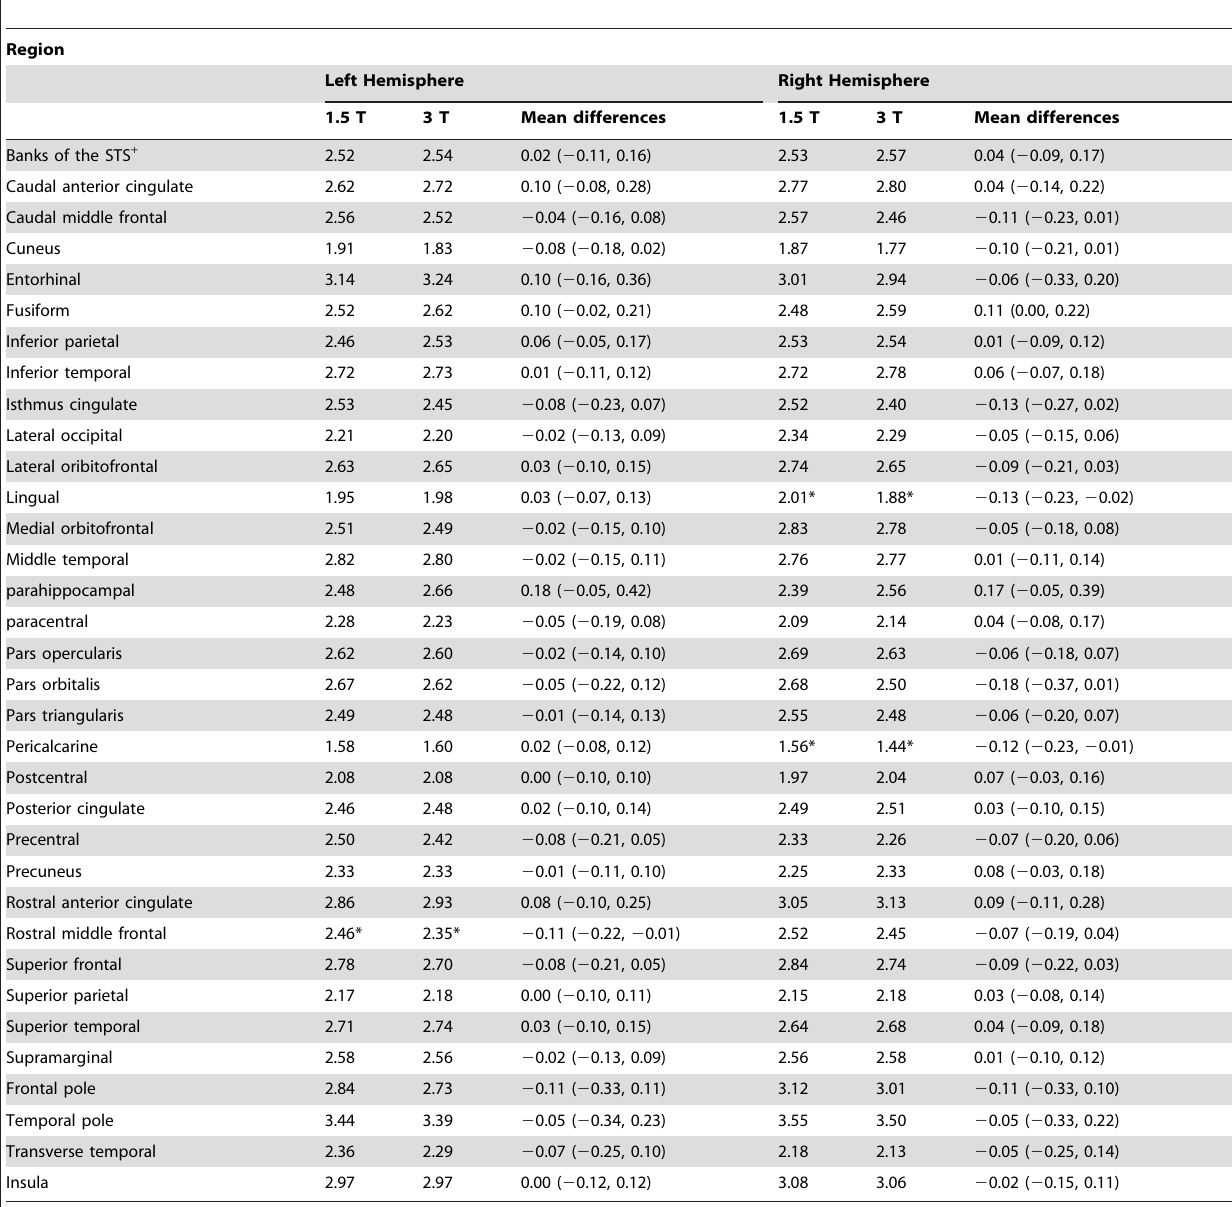
Table 6. Adjusted means and mean differences (95% confidence interval) of regional cortical thickness between 1.5 T and 3 T for females in the age group 41–55 after controlling for confounding